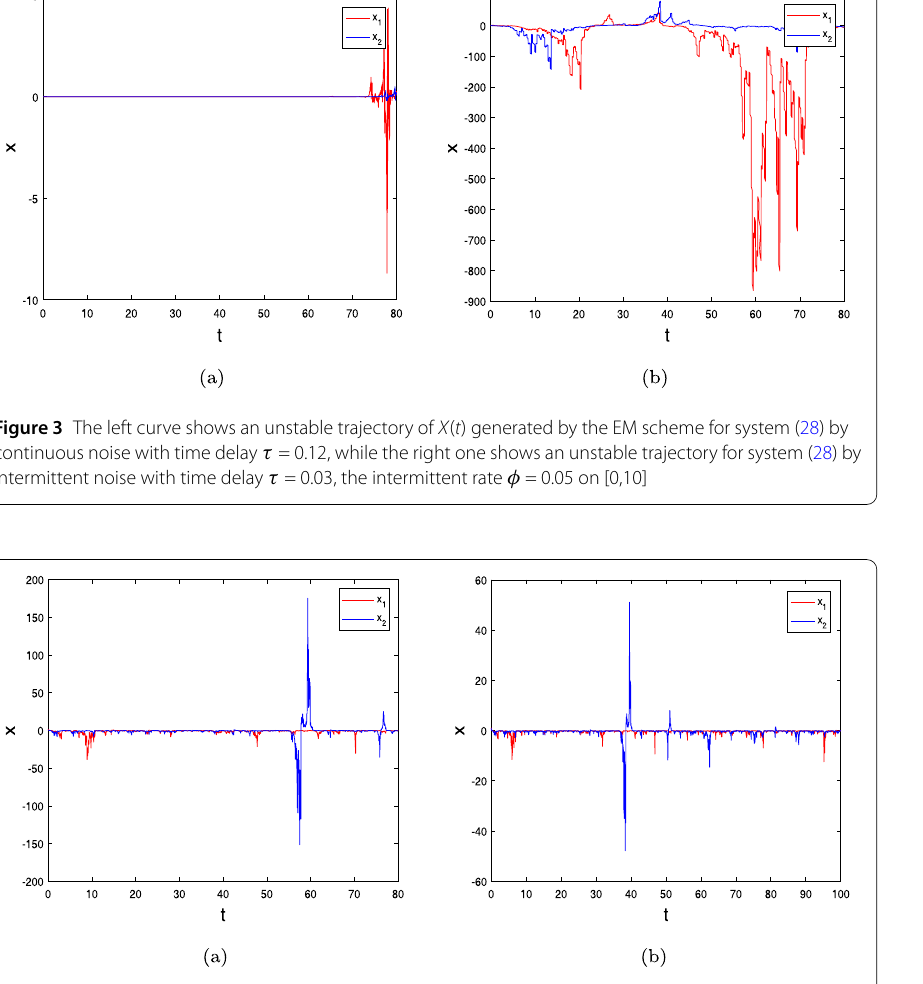
Figure 4 The left curve shows a stable trajectory of X ( t ) generated by the EM scheme for system (28) by intermittent noise with time delay τ = 0.03 (intermittent rate φ = 0.33 on[0,10]), while the right one shows a stable trajectory for system (28) by intermittent noise with time delay τ = 0.03 (the intermittent rate φ = 0.5 on